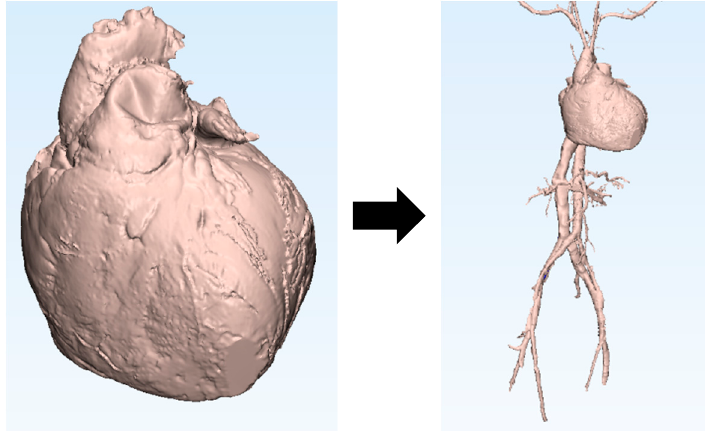
Figure 2. Example of a human heart model with computationally added vasculature.